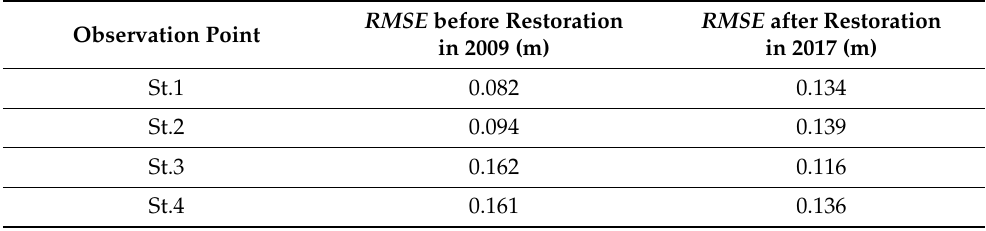
Table 2. RMSEs before and after the meandering stream channel